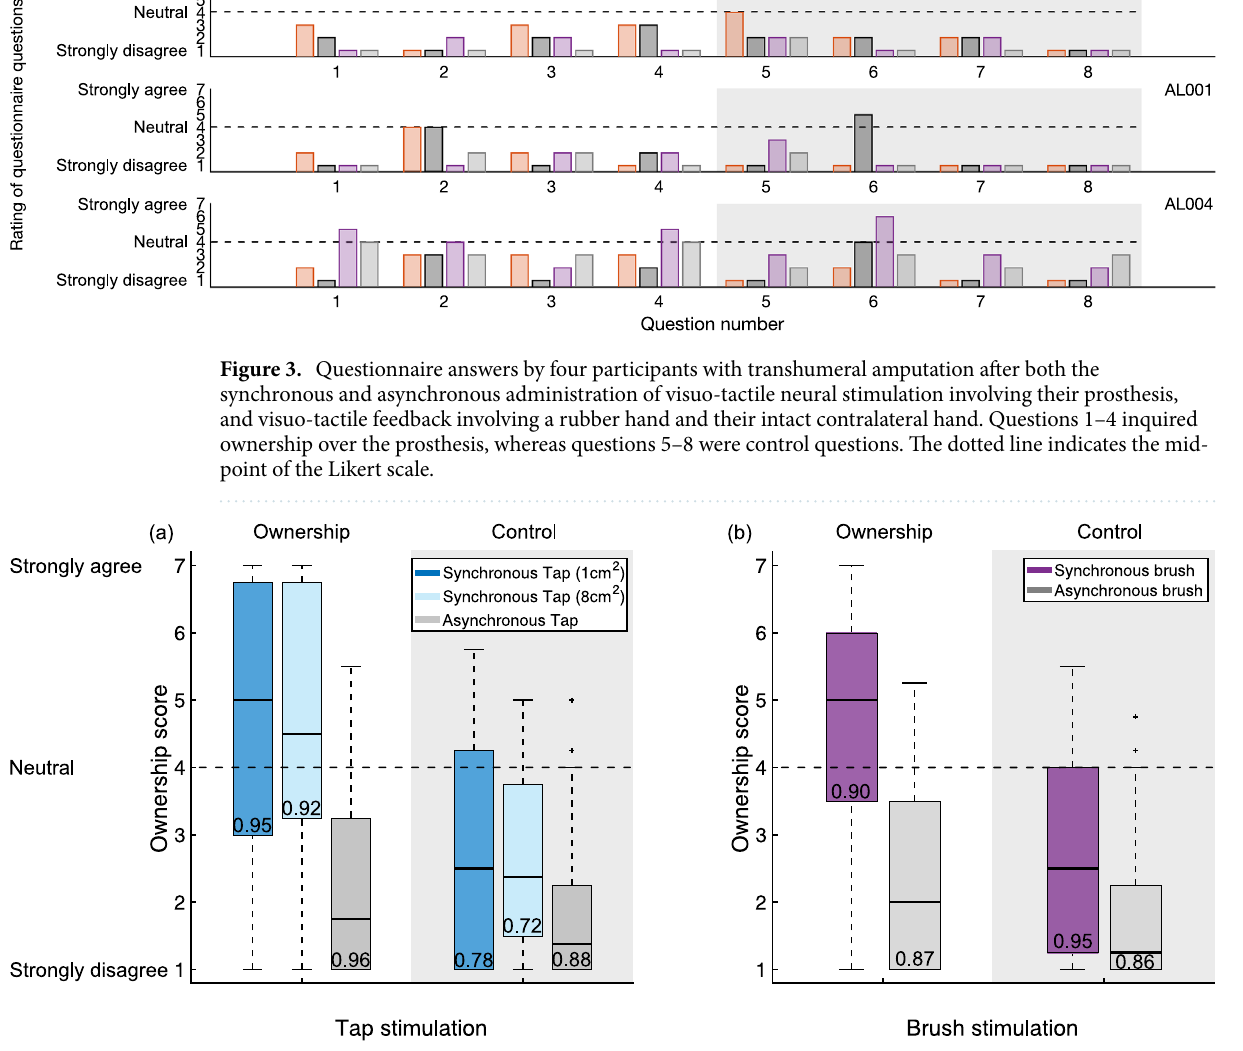
Figure 4. Ownership scores of the 30 able-bodied participants from ( a ) the two tap conditions and ( b ) from the brush condition. Synchronous tapping on a small area was equivalent compared to the brushing condition ( BF 10 = 0.195 ) . Tapping on a bigger area is only anecdotally equivalent to brushing ( BF 10 = 0.345 ) and resulted more likely in smaller ownership scores ( BF − 0 = 0.10 ) . At the bottom of each box, the Cronbach alpha is